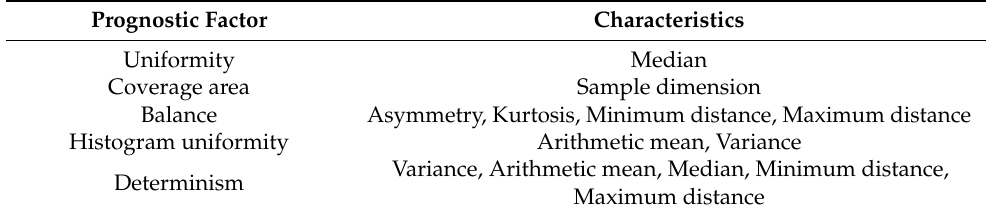
Table 3. Correspondence of characteristics and prognostic factors.